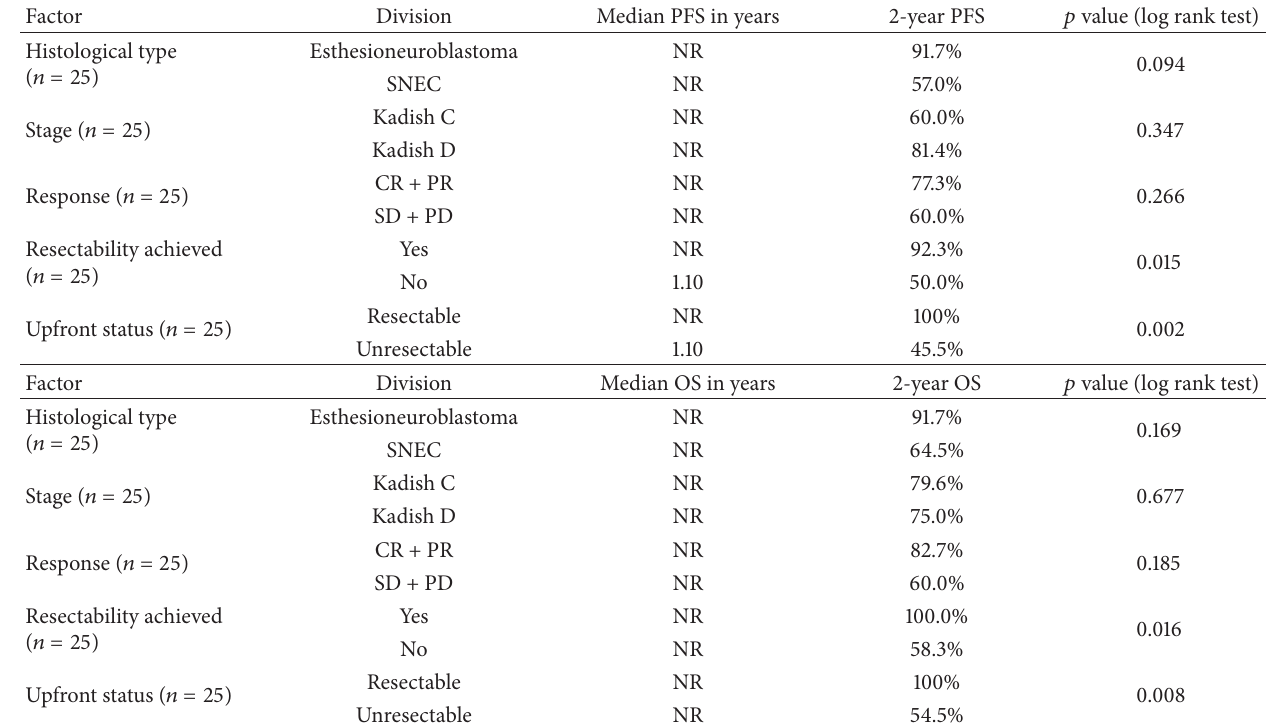
Table 6: The influence of different factors on PFS and